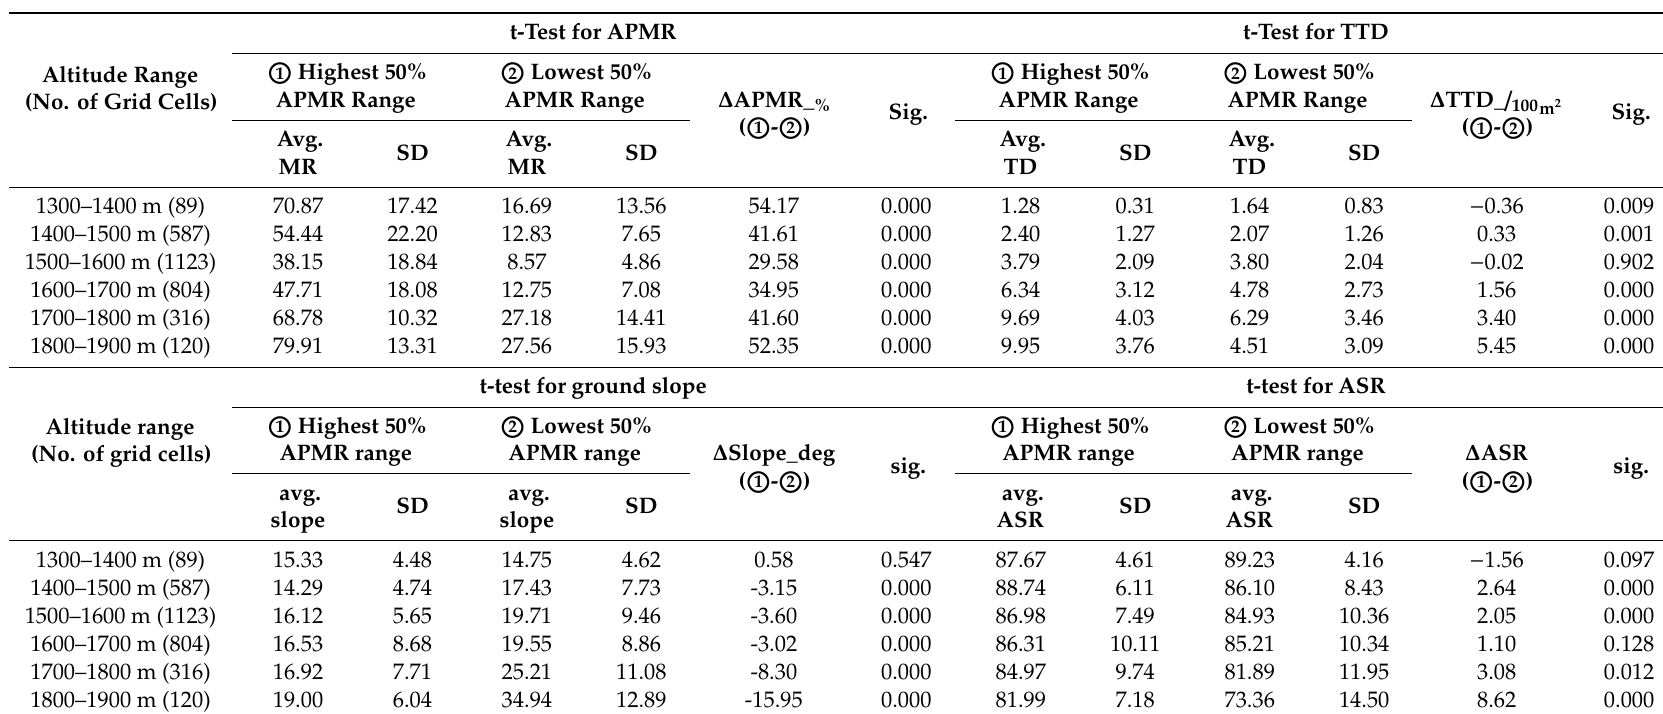
Table 6. t-test for APMR, tree density, ground slope, and ASR between the cell group with the highest 50% APMR range and the cell group with the lowest 50% APMR range within each 100 m altitudinal interval from 1300 m to 1900